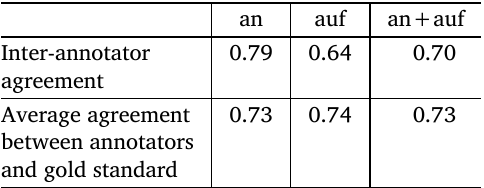
Inter-annotator agreement and comparison of the gold standard and the human ratings (Fleiss’ (cid:20)